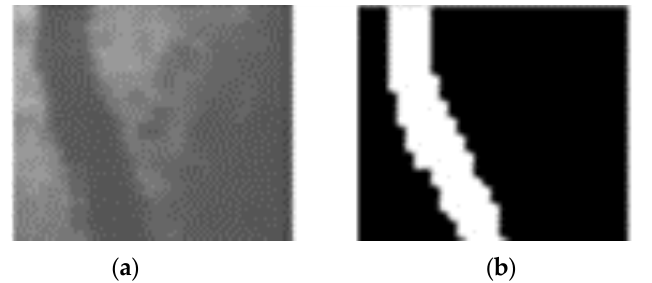
Figure 3. Random cropped patches. ( a ) Cropped patch from original fundus image after the preprocessing steps; ( b ) The corresponding cropped patch of the manual segmentation image.